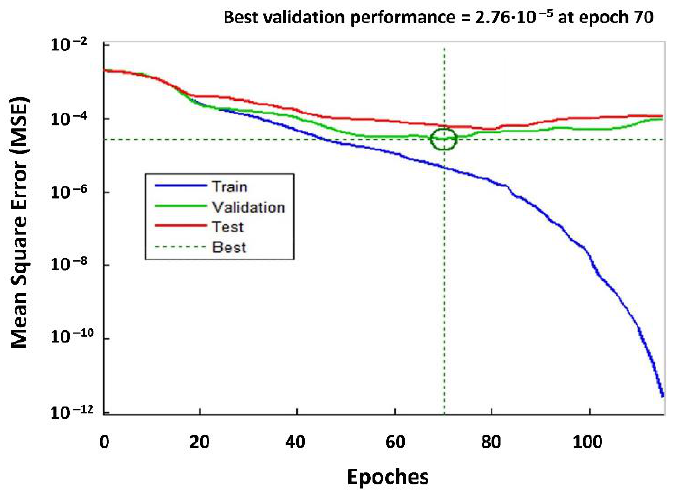
Figure 3. ANN training performance.